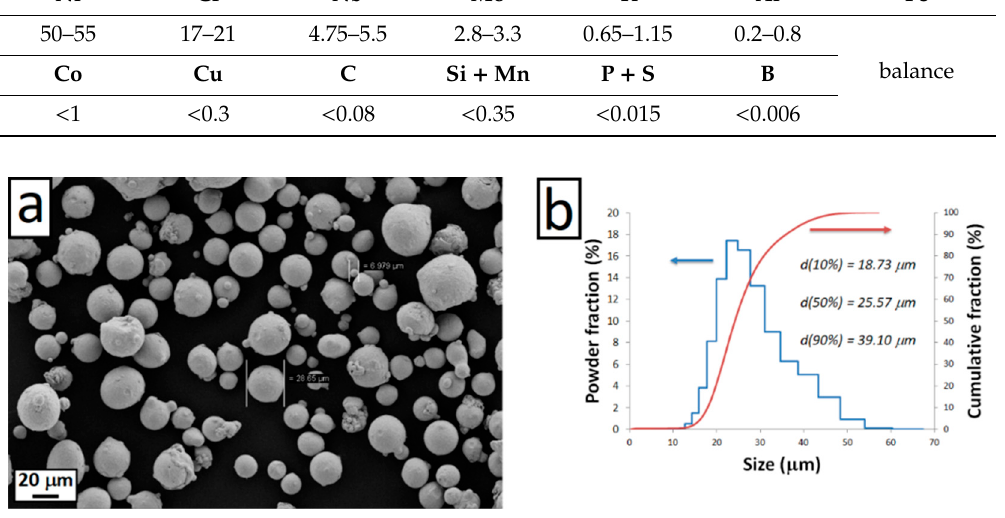
Figure 1. Surface morphology ( a ) and size distribution ( b ) of the Inconel 718 powders used in this